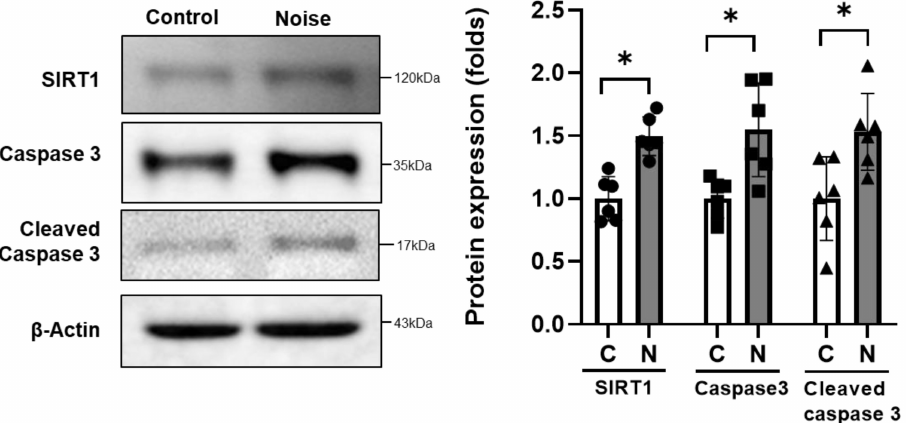
Figure 7. SIRT1, caspase 3, and cleaved caspase 3 expression in the cochlear nuclei after noise exposure ( n = 6 per group). SIRT1, caspase 3, and cleaved caspase 3 expressions were higher in the noise-exposed group (* p < 0.05; unpaired t -test between control and noise-exposed rats; C: control rats; N: noise